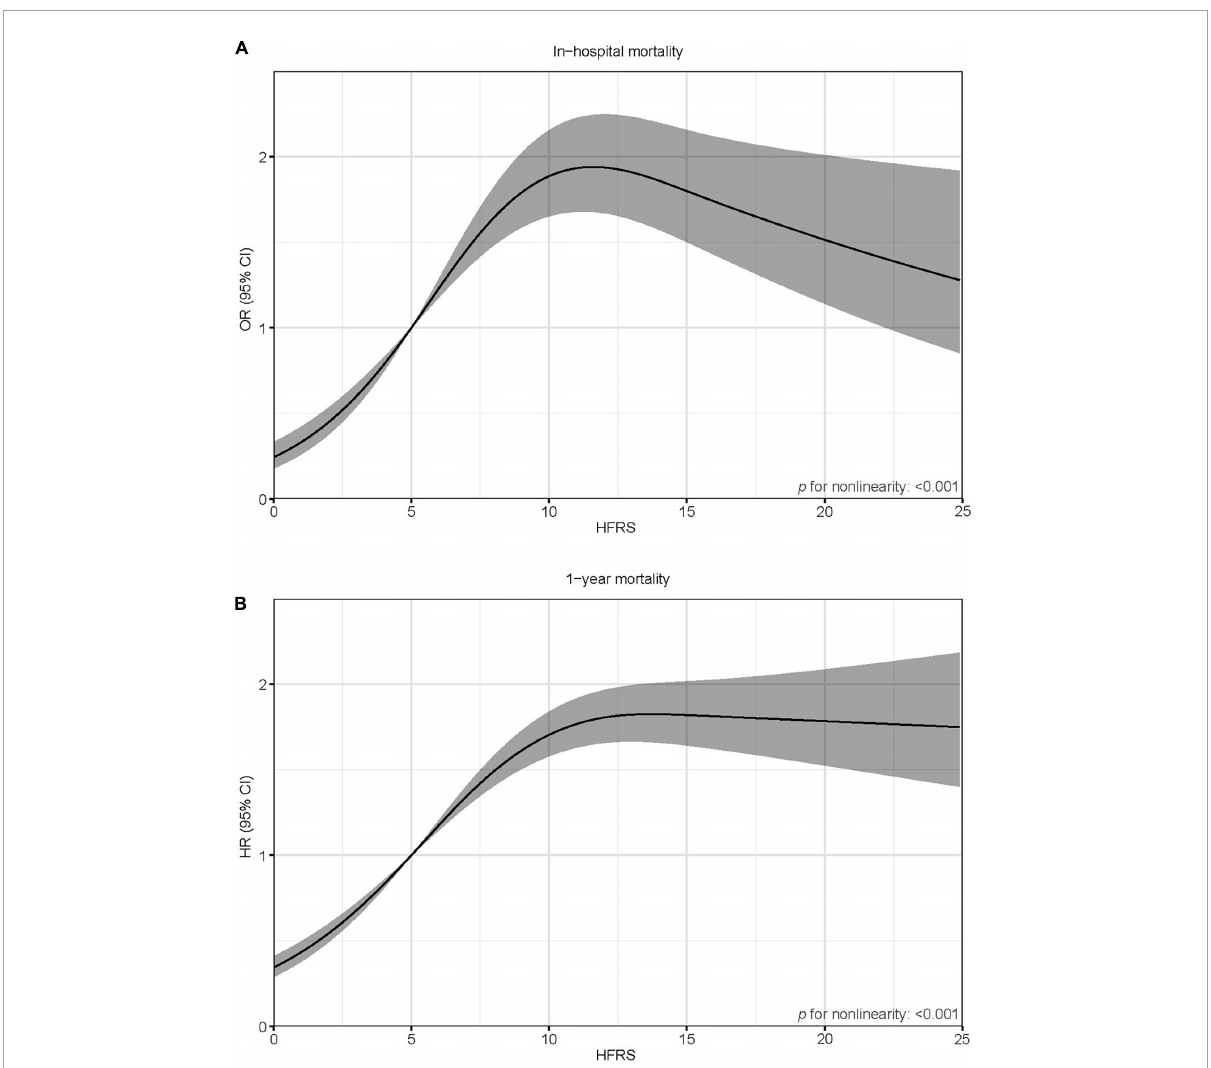
FIGURE3 Spline curves showing the association of the HFRS as a continuous variable with in-hospital mortality (A) and 1-year mortality (B) . Spline curves were adjusted for age, sex, ethnicity, the CCI, AMI type, and SOFA